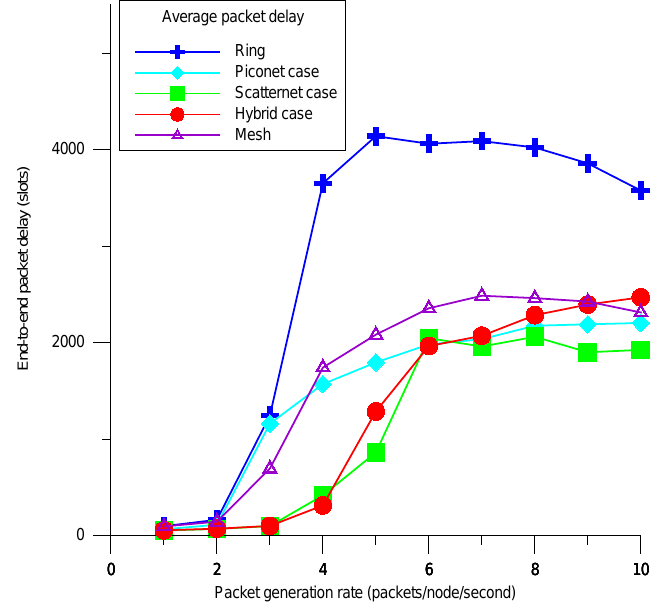
Figure 11. The average packet delay performance of the RMR algorithm.